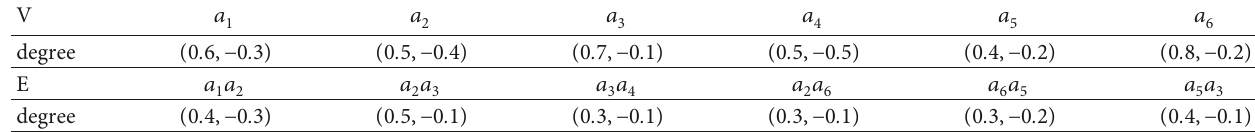
Table 1: Bipolar-valued fuzzy membership